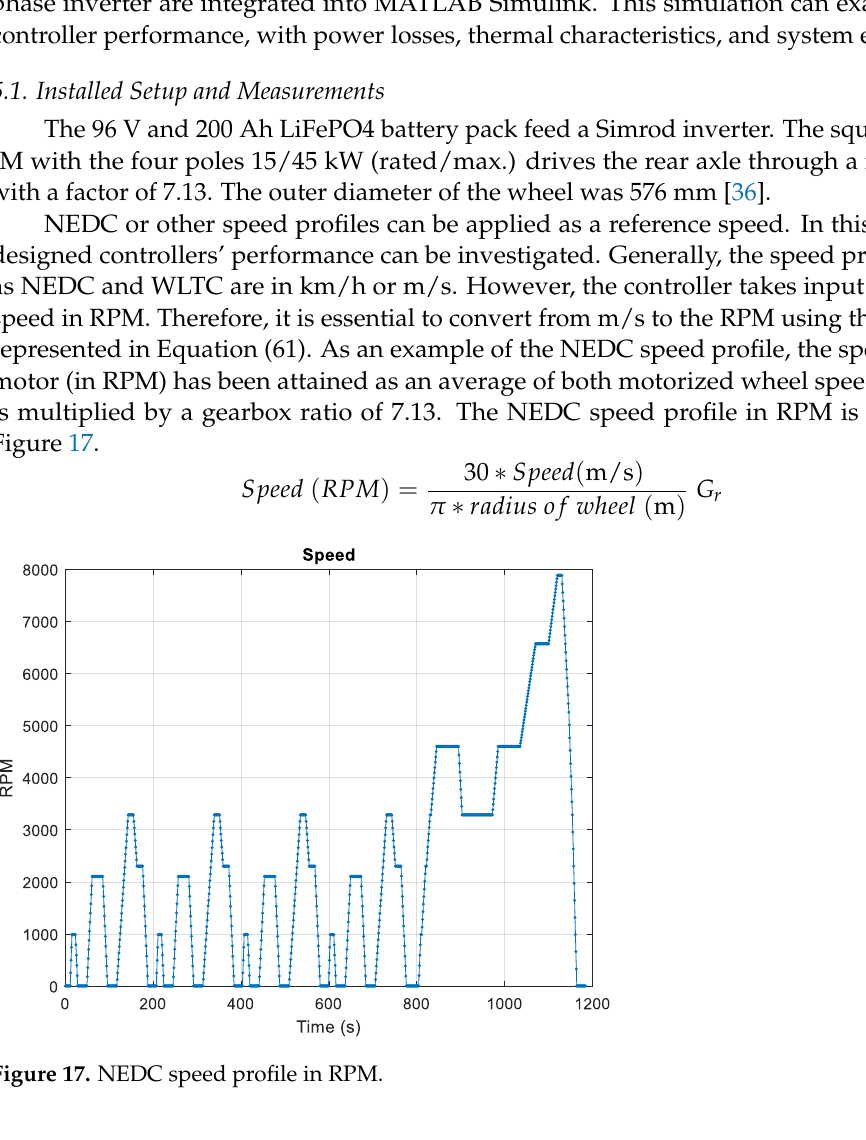
Figure 18. Instrumental powertrain schematic view. The data are logged from the installed test setup [36], as shown in Figure 19 , and used to validate the simulation model. The DC side of the three-phase inverter is connected to the battery, and the AC side is connected to the three-phase induction motor. DC and AC voltages and currents are measured using transducers. The Kistler RoaDyn wheel force transducer measures the 6-DOF forces and the wheel ’ s speed and torque. The throttle device is connected to the inverter to adjust the throttle input. The electrical current and voltage are measured on the inverter ’ s DC as well as AC sides using the three voltage probes (Tektronix P5200A) and the three zero-flux current transducers (LEM IN 1000-S) [36]. The data acquisition has been made with the Siemens (SCADAS) mobile system at a different sample rate that depends on the bandwidth of examined quantities. Particularly for phase voltages, high-frequency measurement was needed. The square wave character of the PWM AC voltage refers to the presence of an inverter’s 10 kHz switching frequency. Therefore, the electrical quantities such as voltages and currents are logged at a sample rate of 204.8 kHz. In addition to the 92 kHz cut-off frequency built-in anti-aliasing filter, an additional low pass filter (zero phase) of 5 kHz cut-off frequency has been fitted. These filters wash out switching harmonics from high-frequency Yokogawa measurements.